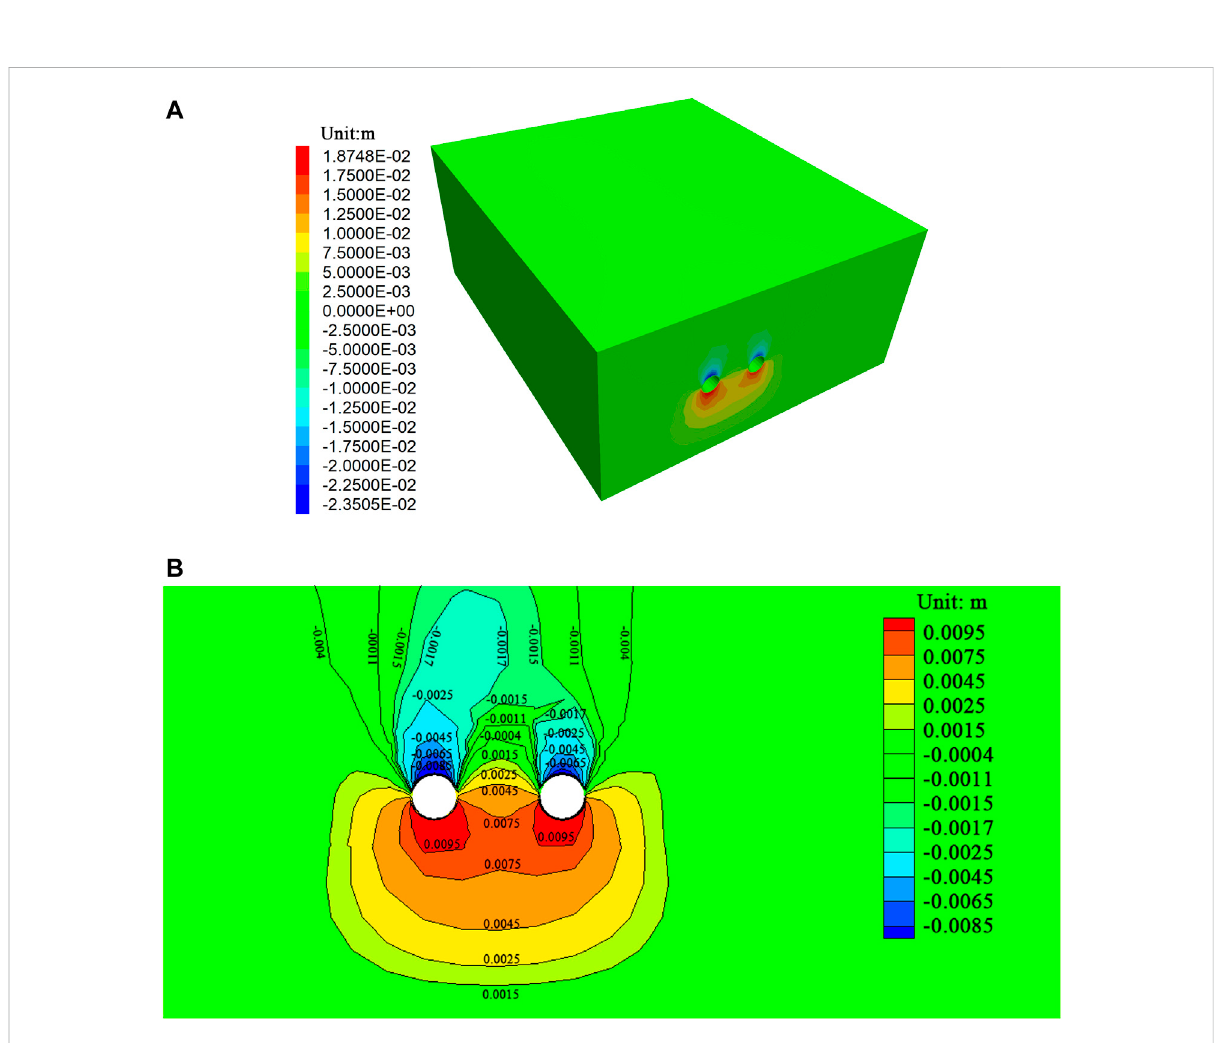
FIGURE 7 Vertical deformation contourofrock stratainthedouble-linetunnel boring. (A) Settlementnephogram ofthesurrounding rock. (B) Settlement nephograms at K36 +